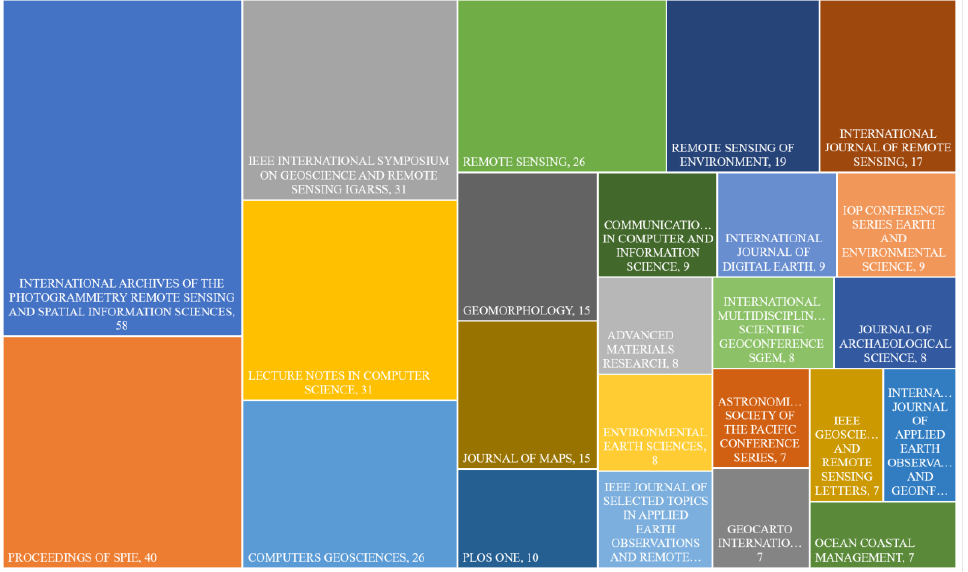
Figure 3. A treemap of GE-based papers published in Top 25 journals, and J. Archaeol. Sci. is 15th. The numbers behind the journals’ titles represent the counts of published contributions. The search was conducted on 15 May 2018.